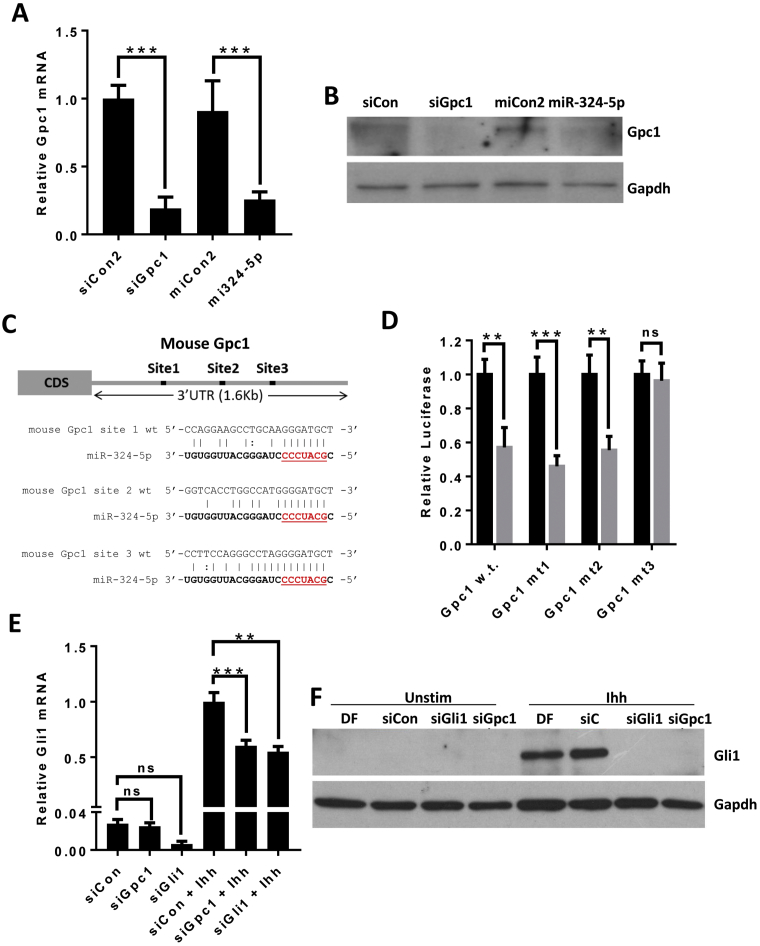
miR-324-5p targets Gpc1 to regulate Hh signalling in mouse C3H10T1/2. (A) Real time RT-PCR analysis of Gpc1 mRNA following siGpc1 or miR-324-5p transfection. Data are presented as SEM. (B) Western blot analysis of Gpc1 protein following siGpc1 and miR-324-5p transfection. (C) Schematic showing potential interaction of miR-324-5p with 3 different binding sites in mouse Gpc1 3′UTR. (D) pMIR reporter plasmid containing either wild type, mutant site 1, mutant site 2 or mutant site 3 mouse Gpc1 3′UTR down stream of luciferase was transfected into C3H10T1/2 cells with either miCon2 or miR-324-5p. Data were normalised to miCon2 and plotted as relative luciferase light units. Data were combined from 5 independent experiments, each n ≥ 6. (E) siGli1 and siGpc1 effect on basal and Ihh stimulated Gli1 mRNA expression. C3H10T1/2 cells were transfected with non-targeting siCon or siRNA against Gpc1 or Gli1 for 24 h. Cells were then serum starved for 24 h and either left unstimulated or stimulated with Ihh (2 μg/ml) for 24 h. Data were combined from 4 independent experiments, each n = 4. (F) siGli1 and siGpc1 effect on basal and Ihh stimulated Gli1 protein expression, cells treated as in D. Representative blot of 3 independent experiments. Throughout statistical differences were calculated using a one-way analysis of variance followed by Bonferroni post hoc test where **p < 0.01, ***p < 0.001, ns = non-significant (p > 0.05).